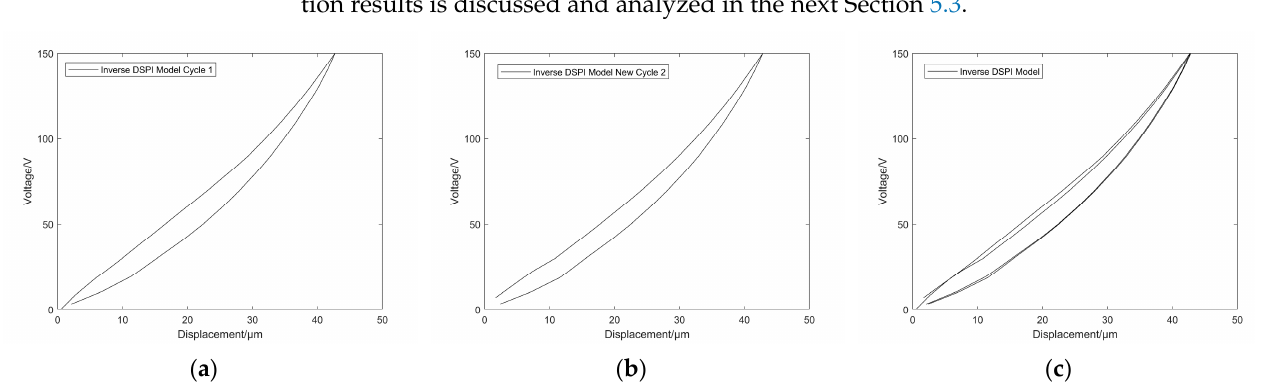
Figure 18. DSPI inverse model: ( a ) the first cycle; ( b ) the new second cycle; ( c ) overall modeling of the DSPI inverse model.